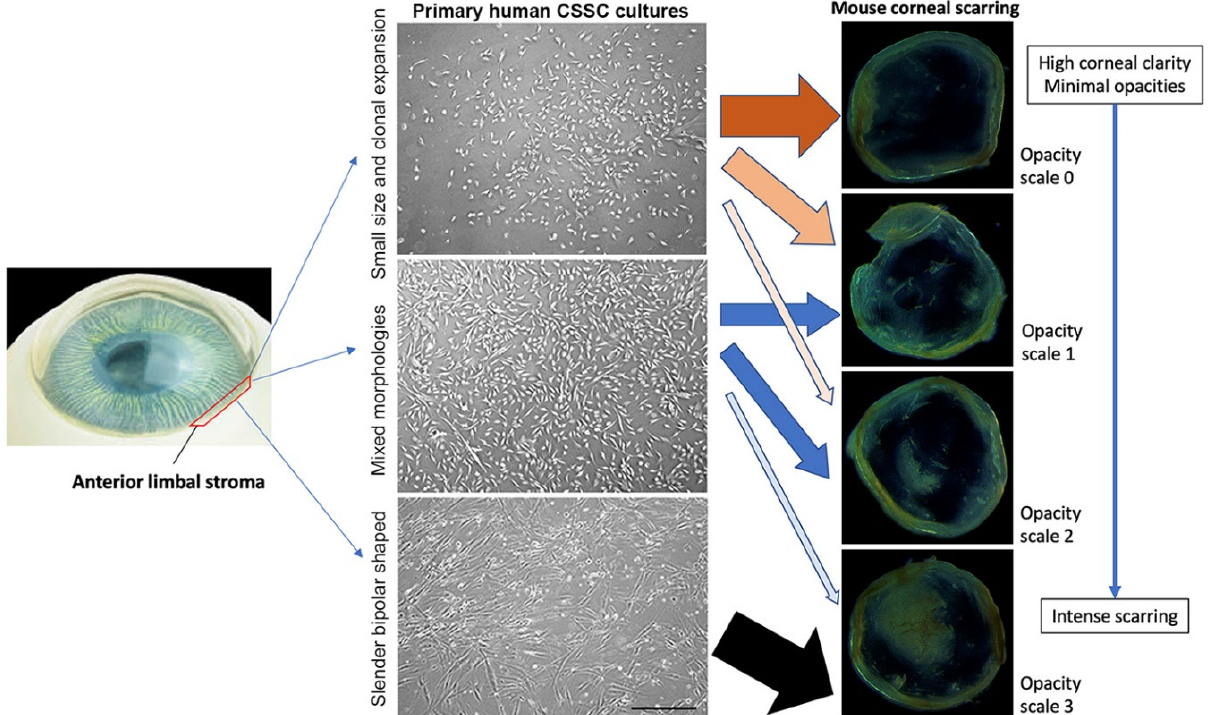
Figure 3. Batch variation of CSSC cultures influencing the treatment outcomes. Primary human CSSC exhibited heterogenous features in the culture, from the cultures with generally small size and clonal proliferation, to mixed morphologies, with slender-shaped cells combined with small-sized cells. While the majority of small-sized CSSC, the cultures could suppress corneal scar formation (brown arrows); other CSSC batches with mixed morphologies provided moderate effects on scar inhibition (blue arrows). Using batches with predominantly slender-shaped cells, the anti-scarring effect was minimal (black arrow). The cultures of these poor-quality cells were usually terminated and discarded; scale bar: 100 µ